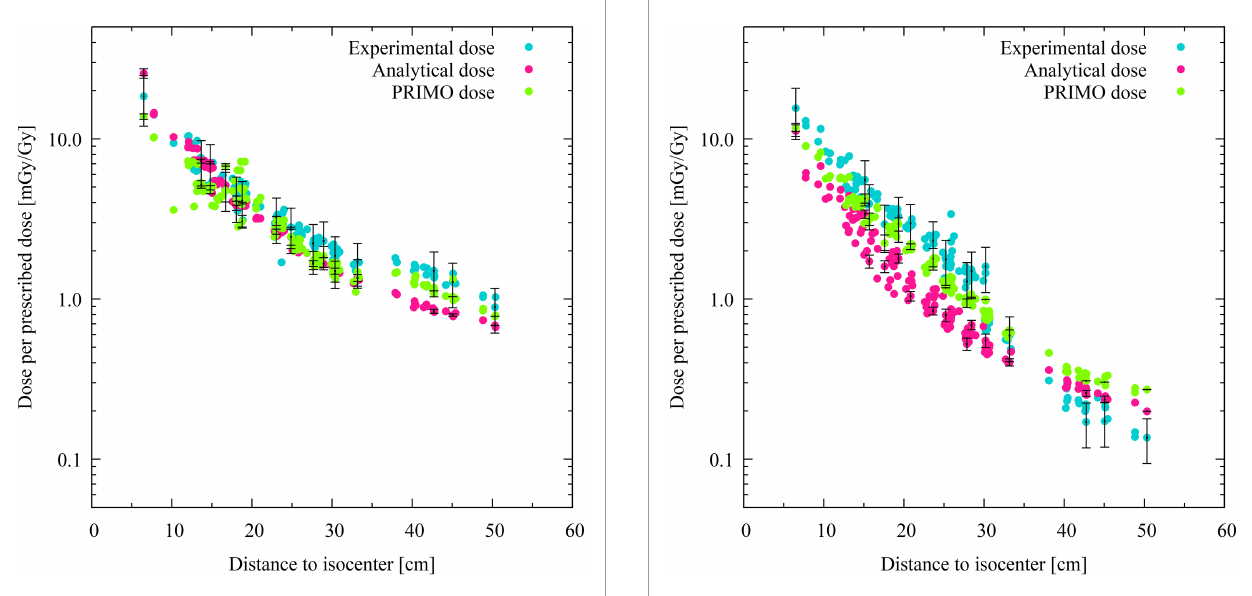
FIGURE 2 | Comparison of experimental, analytical, and simulated data for intensity-modulated radiotherapy. Each colored dot represents one thermoluminescent dosimeter (TLD) position. The distance of the TLD position to the isocenter (in centimeters) is given on the abscissas, while the dose per prescribed dose (mGy/Gy) in logarithmic scale are indicated on the ordinates. The experimental dose distribution is shown with turquoise dots, the analytically calculated absorbed doses with pink dots, and the PRIMO- simulated data with green dots. Statistical uncertainties ( k = 2) are plotted for every twentieth TLD position.